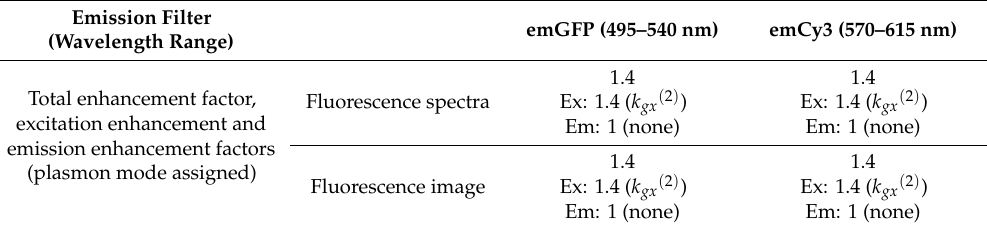
Table 4. Enhancement e ff ect of YG with exCFP for the 1D chip in the epi-optical system.